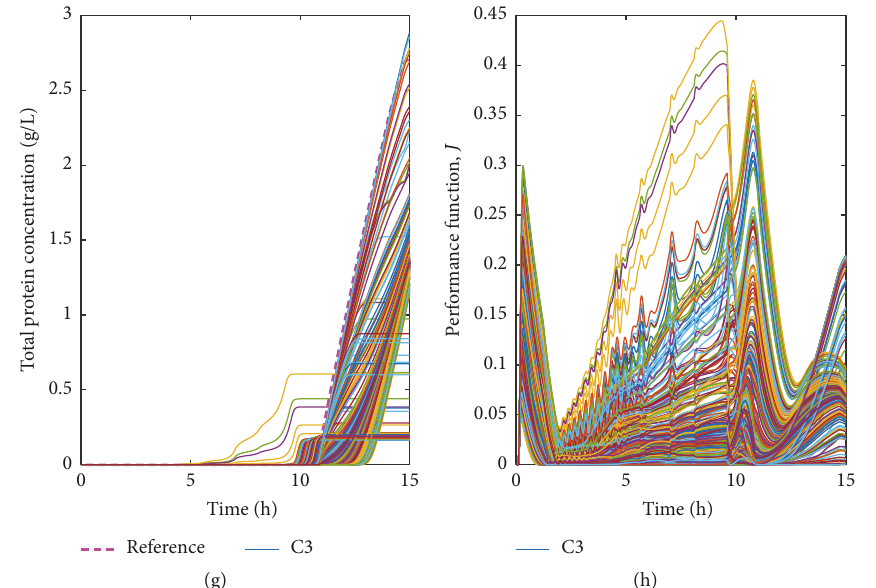
Figure 3: Total protein concentration ((a), (c), (e), and (g)) and performance index 𝐽 ((b), (d), (f), and (h)) for 1,000 random values of 𝑆 𝐹 and 𝑌 𝑆/𝑋 (controllers are indicated in each figure).